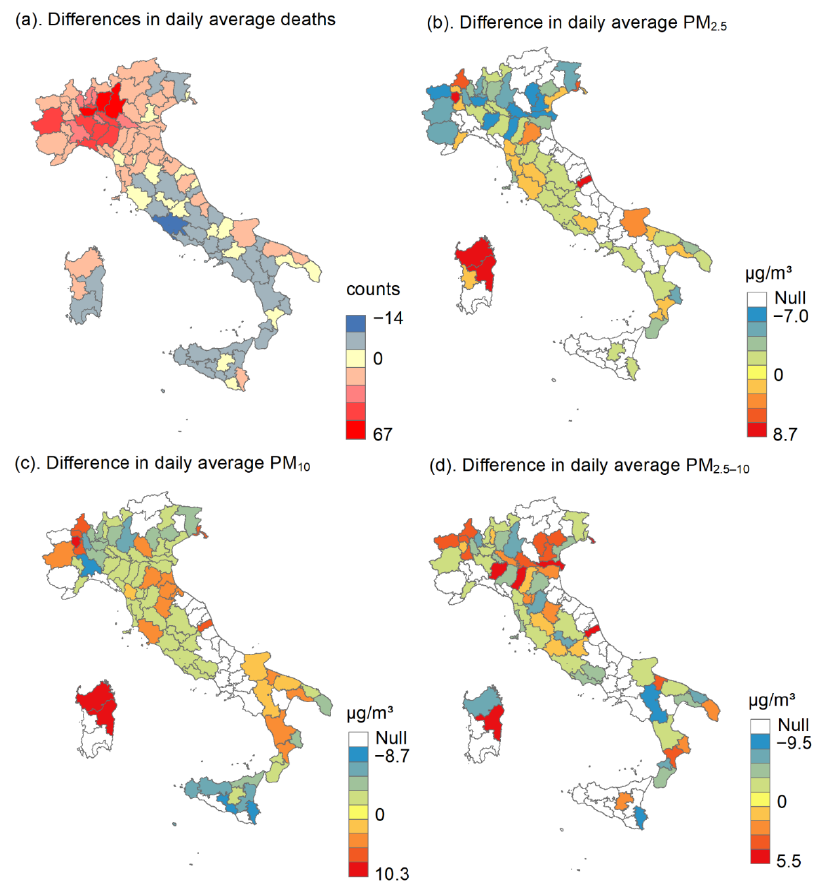
Figure 1. Difference in daily average deaths and the particulate matter (PM 2.5 with an aerodynamic diameter ≤ 2.5 µ m; PM 10 , ≤ 10 μ m; PM 2.5–10 , 2.5–10 μ m) in 107 Italian provinces during March and May. (a) Differences in daily average deaths, (b) Differences in daily average PM 2.5 , (c) Differences in daily average PM 10 , and (d) Differences in daily average PM 2.5–10 .